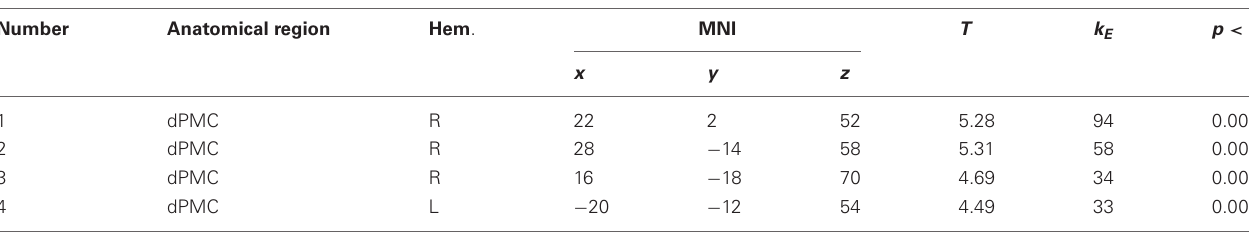
Table 4 | Training-induced decrease (T1 > T2) of functional recruitment during